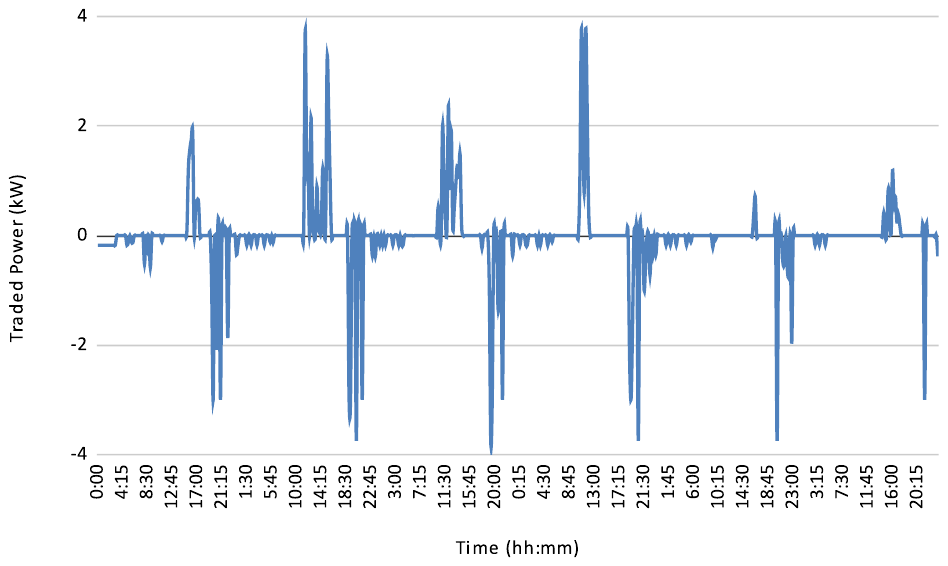
Figure 6. Community storage traded power during simulation in April (load convention: consump- tion is positive).